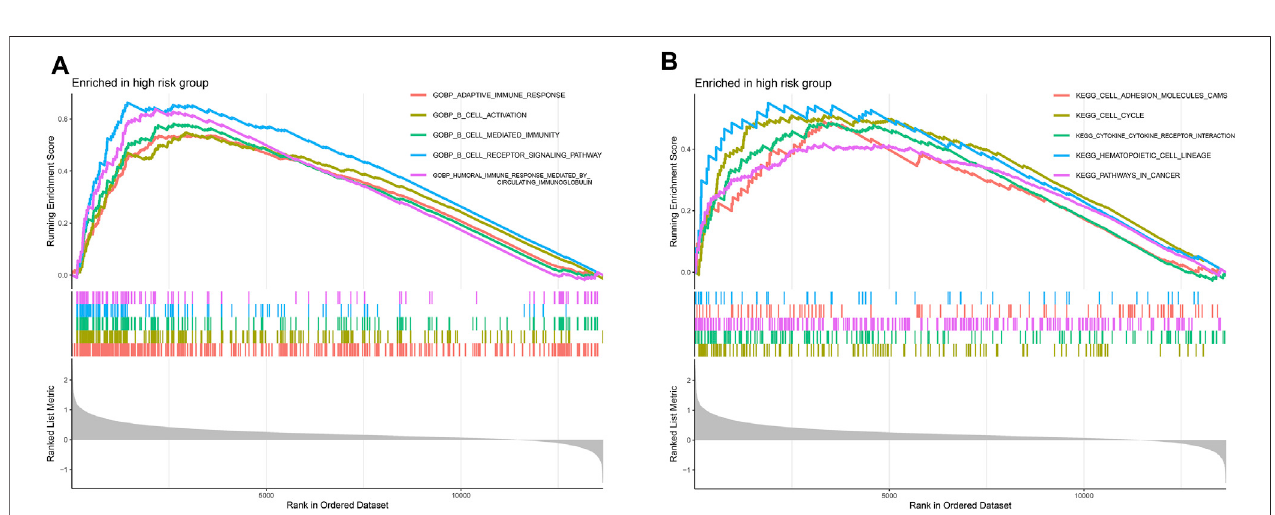
FIGURE 4 | Gene set enrichment analysis (GSEA). (A) Functional enrichment analysis. Multiple immune functions such as adaptive immune response, B cell activation, B cell-mediated immunity, B Cell receptor signaling pathway, and humoral immune response mediated by circulating immunoglobulin were overactivated in high-risk group. (B) Pathway enrichment analysis. The pathways of the high-risk group were mainly enriched in cell adhesion molecules, cell cycle, cytokine receptor interaction, hematopoietic cell lineage, and pathways in